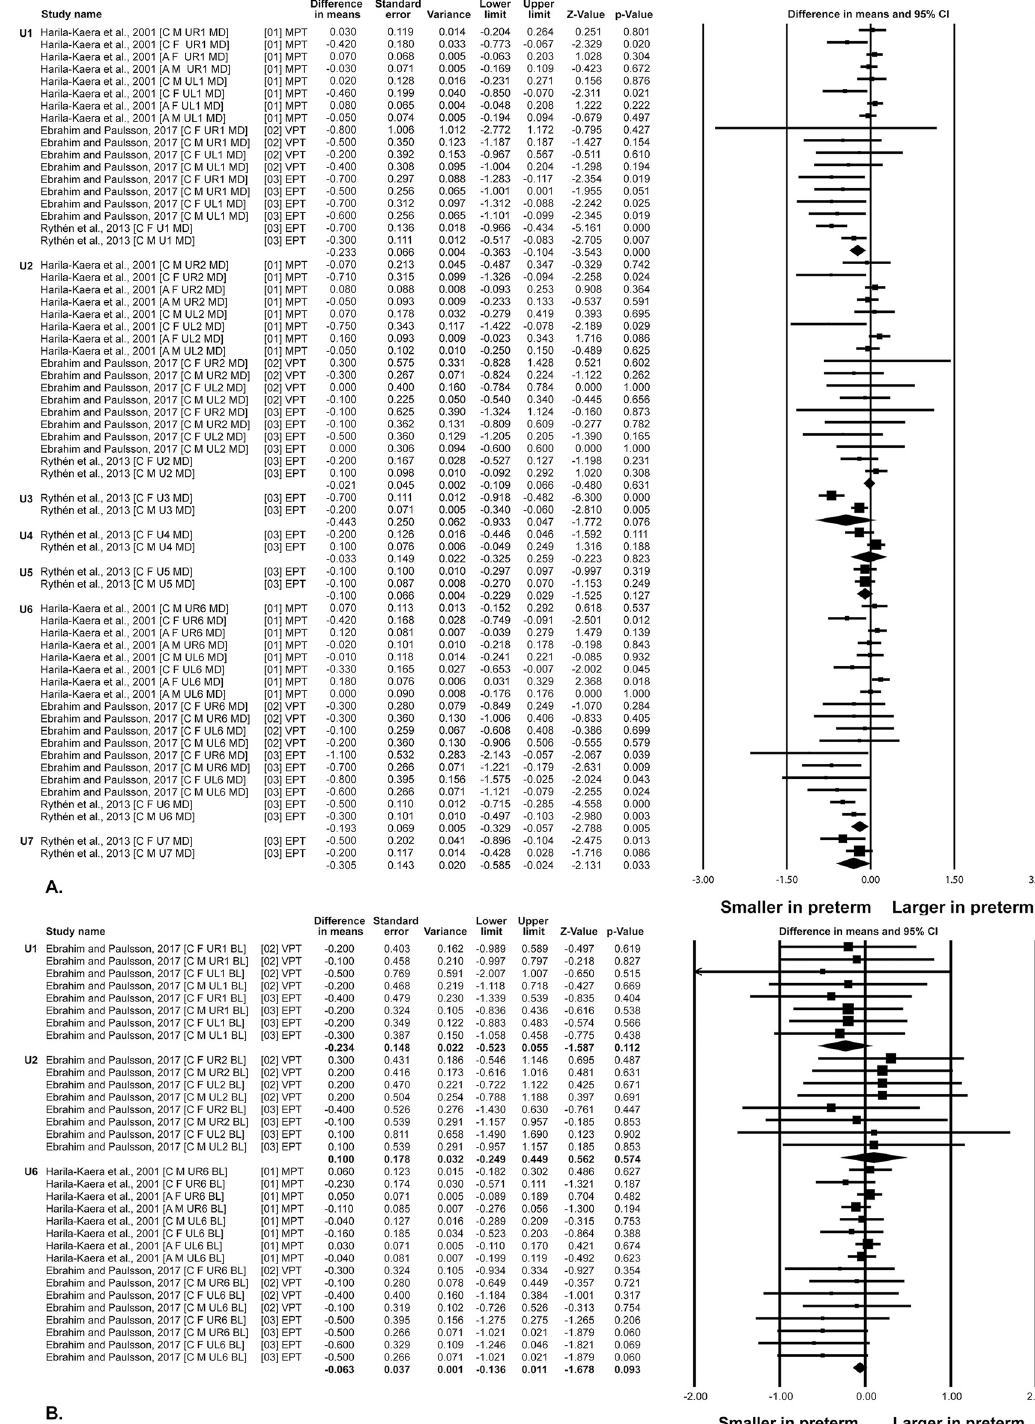
PLOS ONE | https://doi.org/10.1371/journal.pone.0259293 November5,